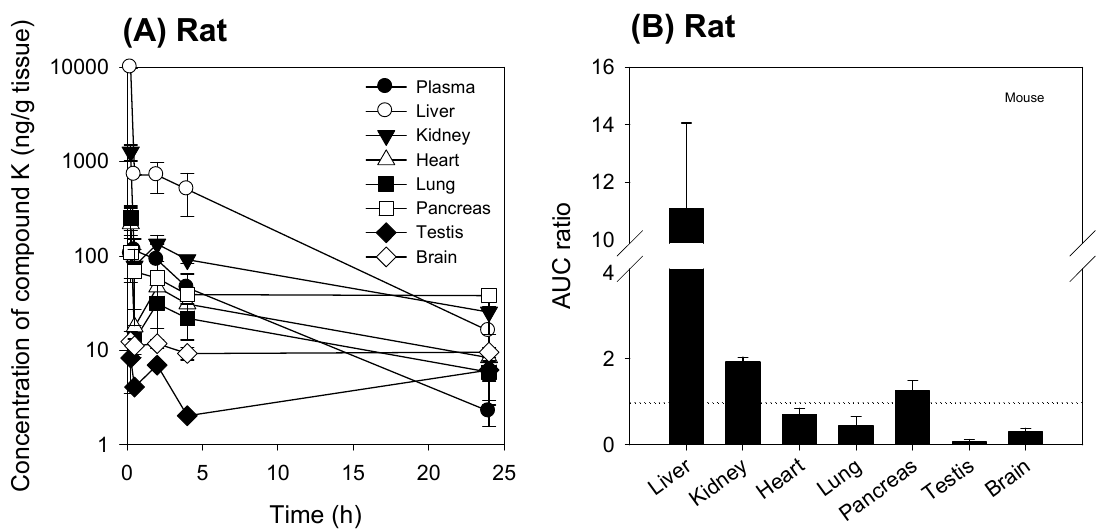
Figure 2. ( A ) Tissue concentration vs. time profile of compound K following intravenous injection of compound K at a single dose of 2 mg/kg in rats. ( B ) AUC ratios (AUC tissue /AUC plasma ) of compound K in the liver, kidney, heart, lung, pancreas, testis, and brain following intravenous injection (2 mg/kg) in rats. AUC was calculated from the data shown in ( A ) and the dotted line in ( B ) represents unity. Data are expressed as mean± standard deviation from four rats at different time points.